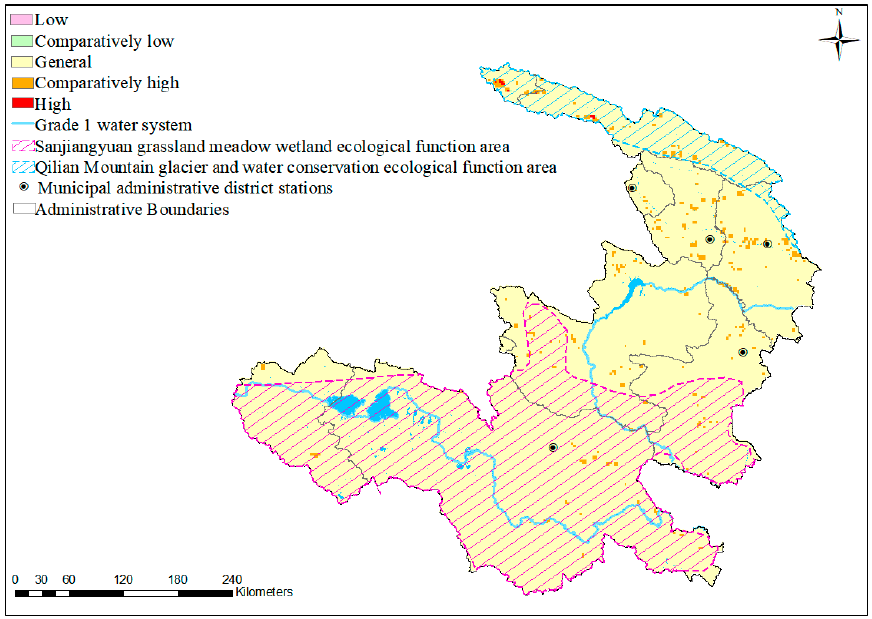
Figure 5. Distribution map of water conservation ecosystem service function stressed